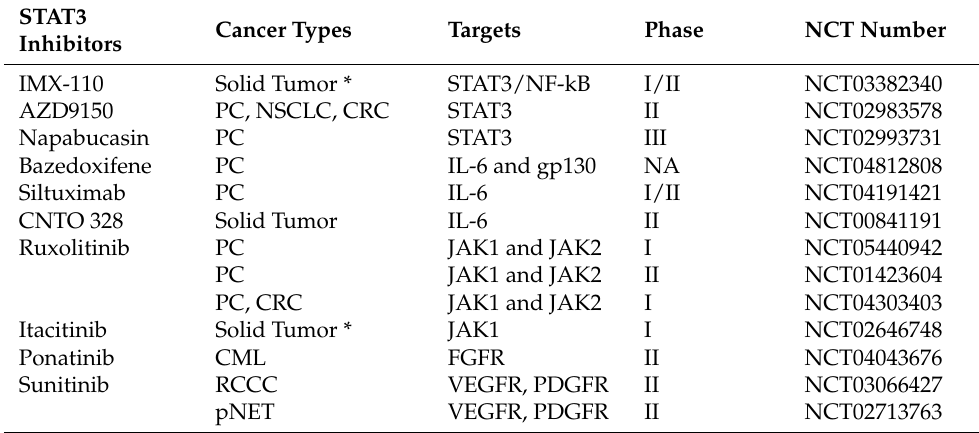
Table 2. STAT3 inhibitors in clinical